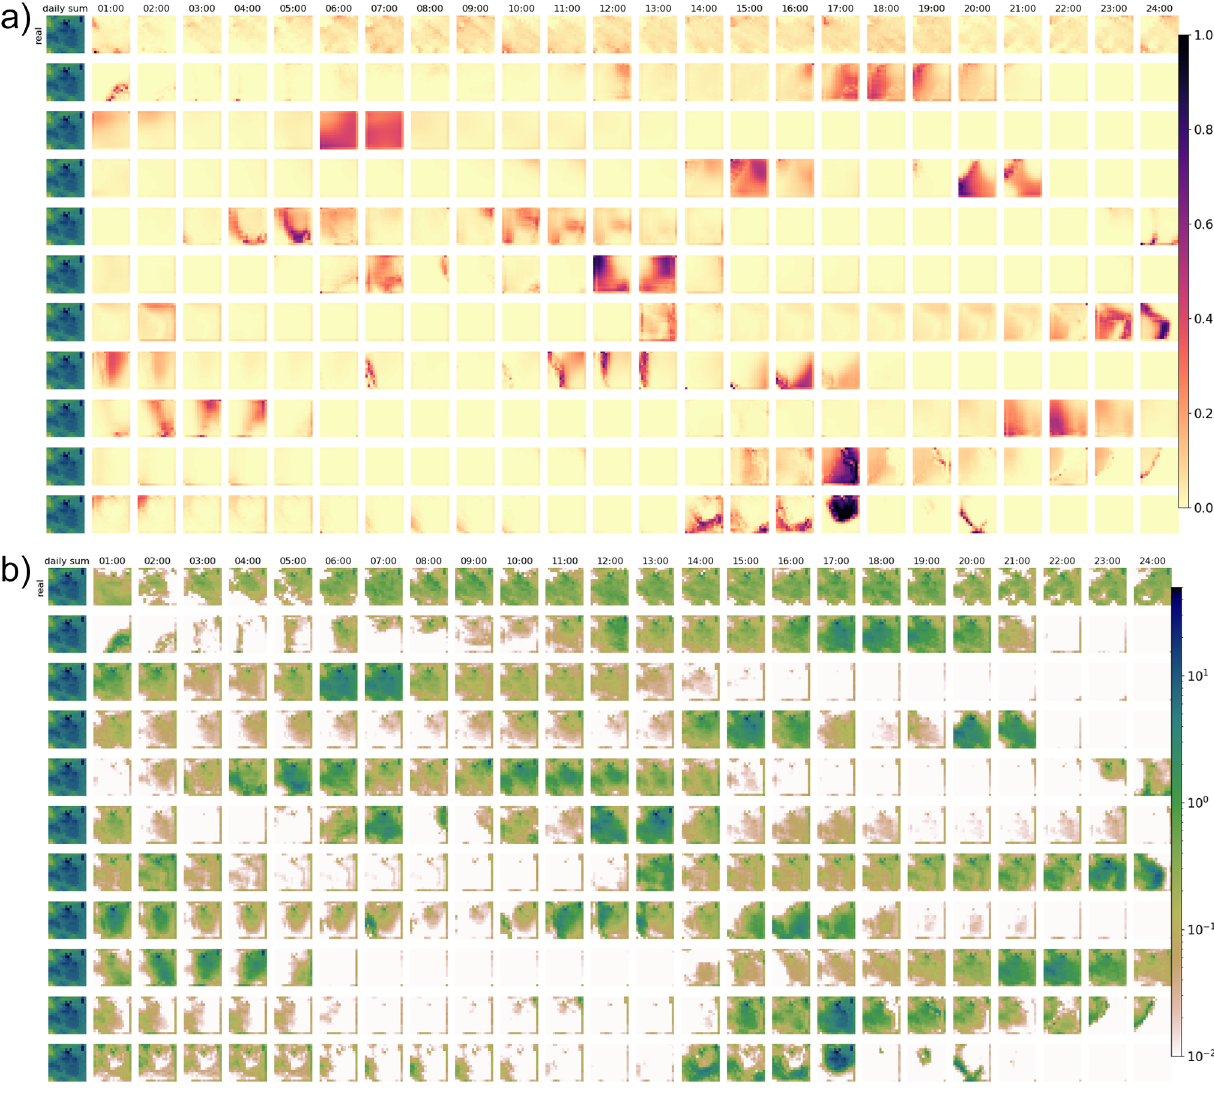
Figure B1. As Fig. 3, but with all hours